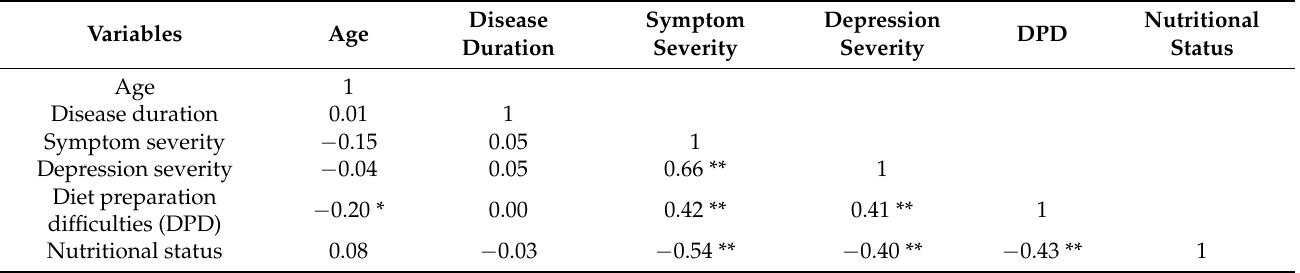
Table 4. Correlations among study variables (N =